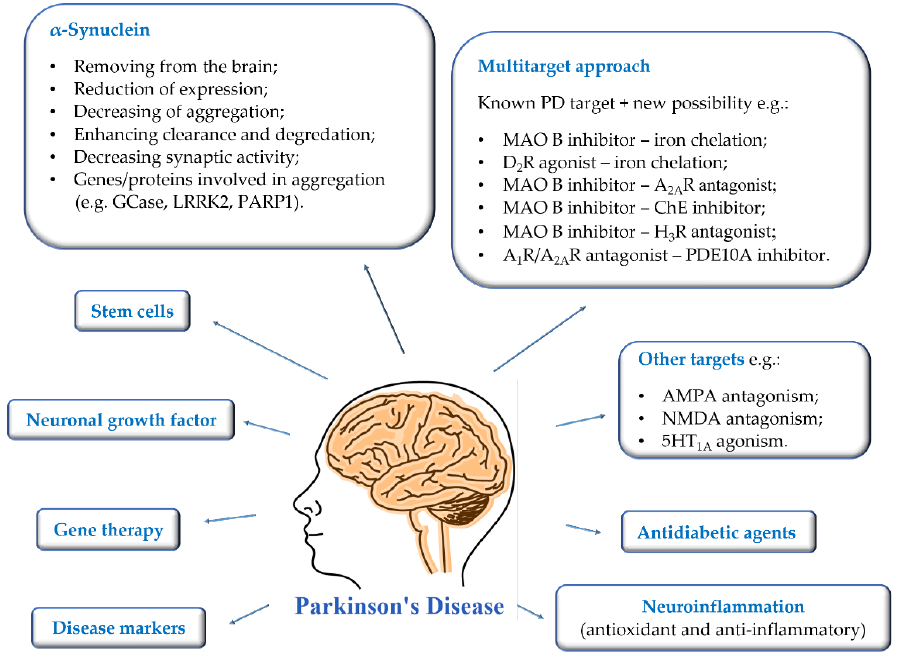
Figure 2. Current suggested approaches to the treatment, diagnosis, and prevention of Parkinson’s disease.